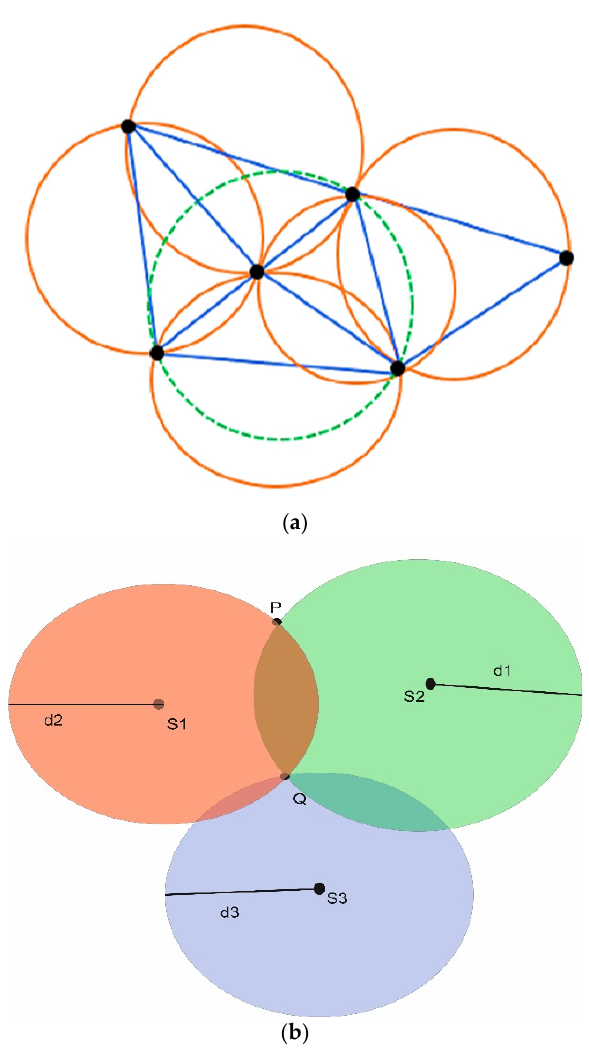
Figure 12. ( a ) Delaunay triangulation; ( b ) Trilateration.